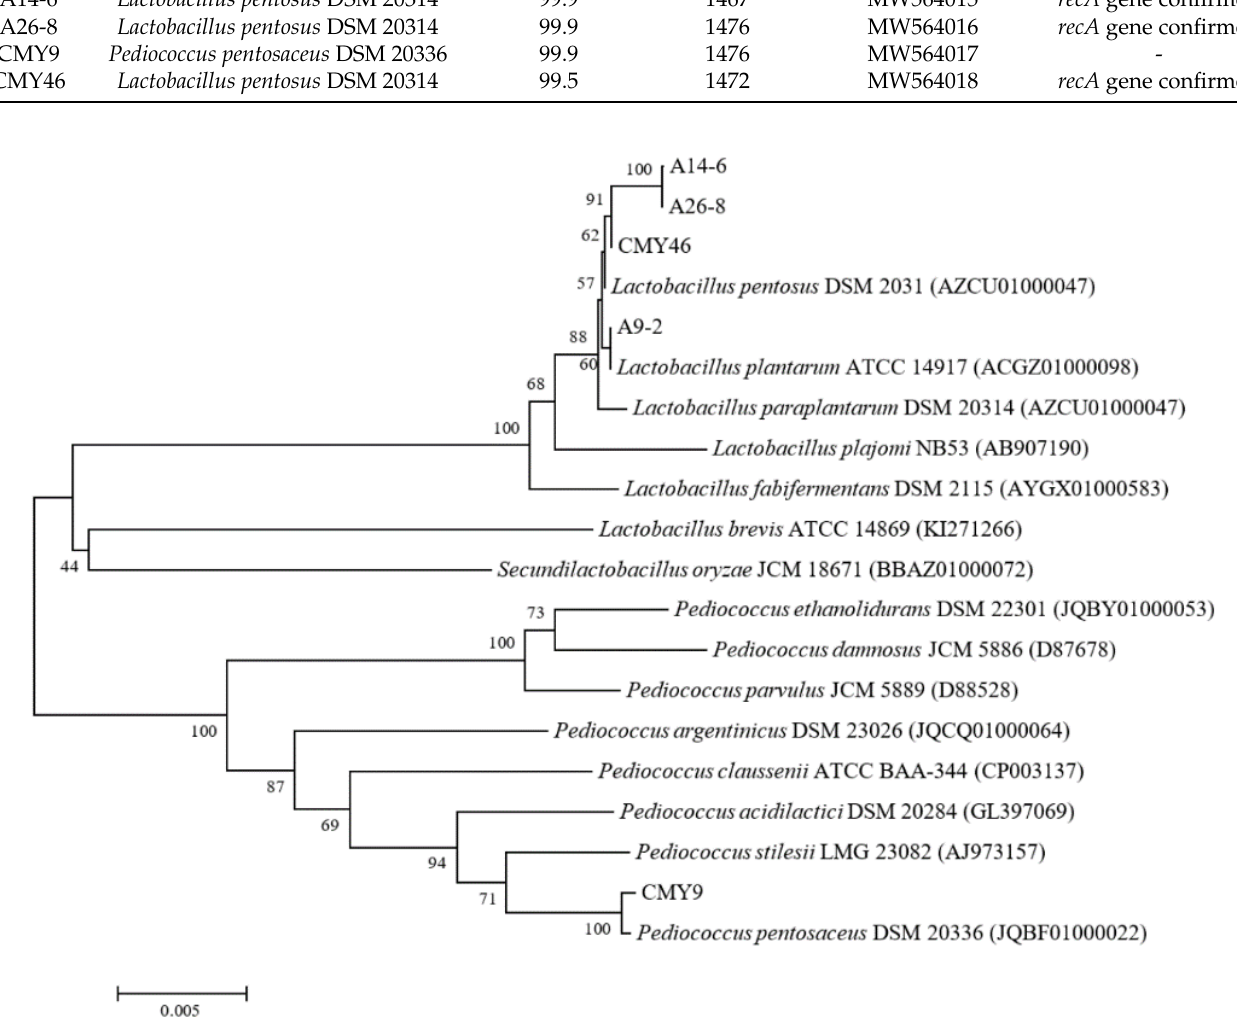
Figure 1. Phylogenetic tree of five selected LAB isolates based on 16S rRNA gene sequence analysis and other related species.